Question: Give a one-sentence summary of this figure.
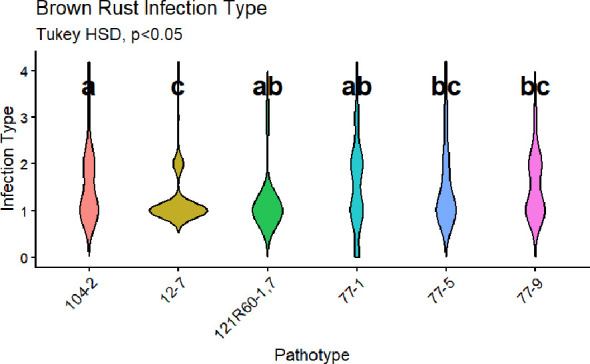
Answer: Violin plots showing leaf rust infection type (0-4 scale) across six pathotypes in RIL population. Tukey HSD groupings (p<0.05): pathotype 104-2(a, most resistant); 12-7 (c, most virulent); 121R60-1, 7, 77-1, 77-5, 77-9 (ab/bc, intermediate).